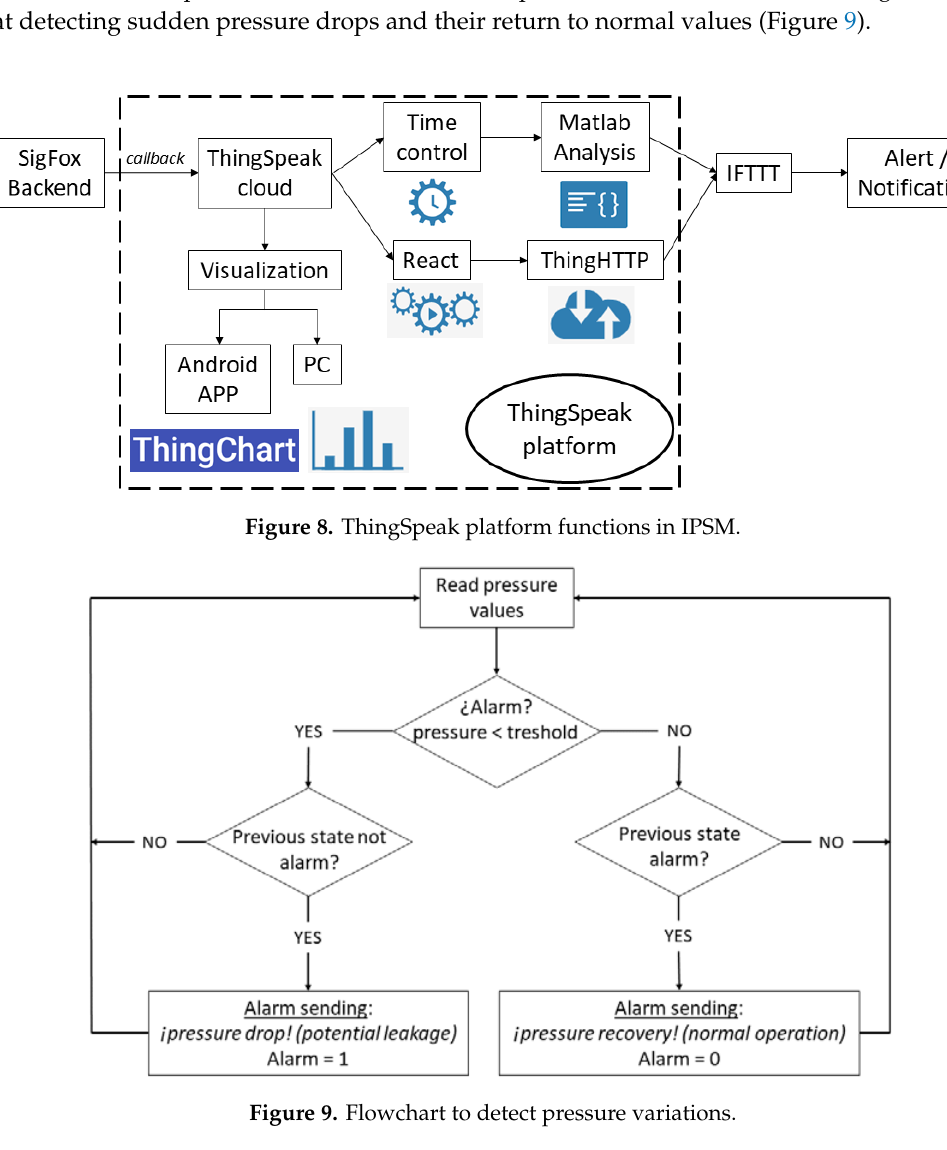
Figure 9. Flowchart to detect pressure variations.